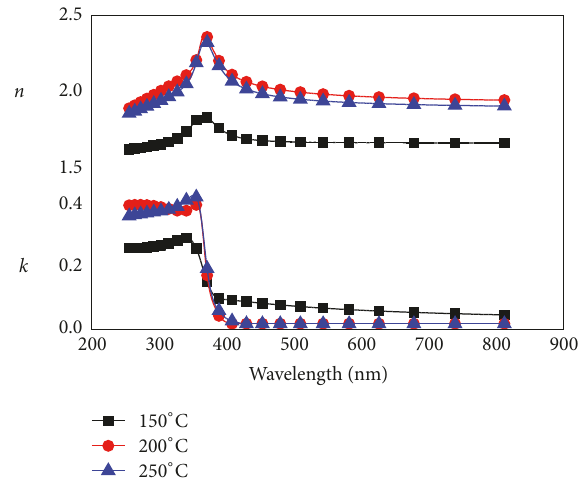
Figure 7: Dispersion curves of refractive index ( 𝑛 ) and extinction coefficient ( 𝑘 ) of ZnO thin films with thickness of 200 nm deposited at different substrate temperature denoted on the